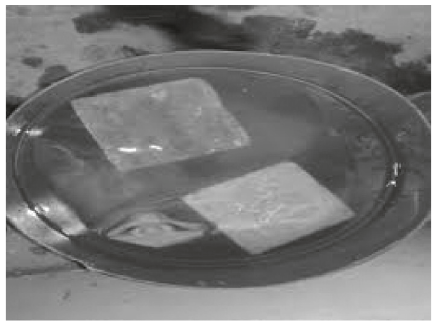
Figure 5: Specimen immersed in Hcl.